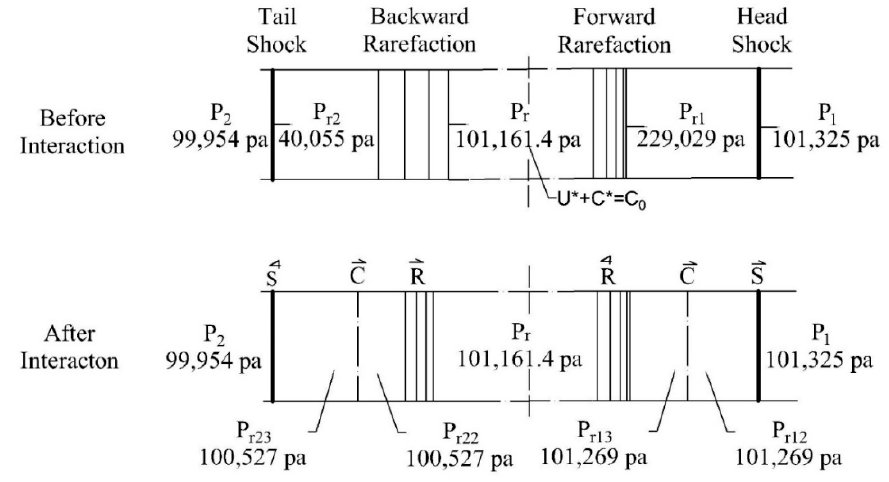
Figure 7. Flow field resulting from interactions.